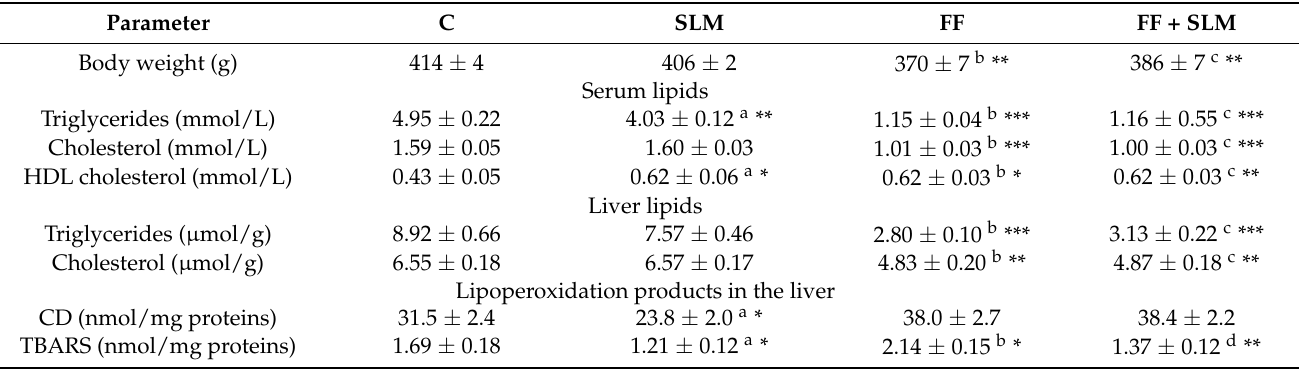
Table 1. Body weight and metabolic parameters in HHTg rats treated with silymarin, fenofibrate, and their